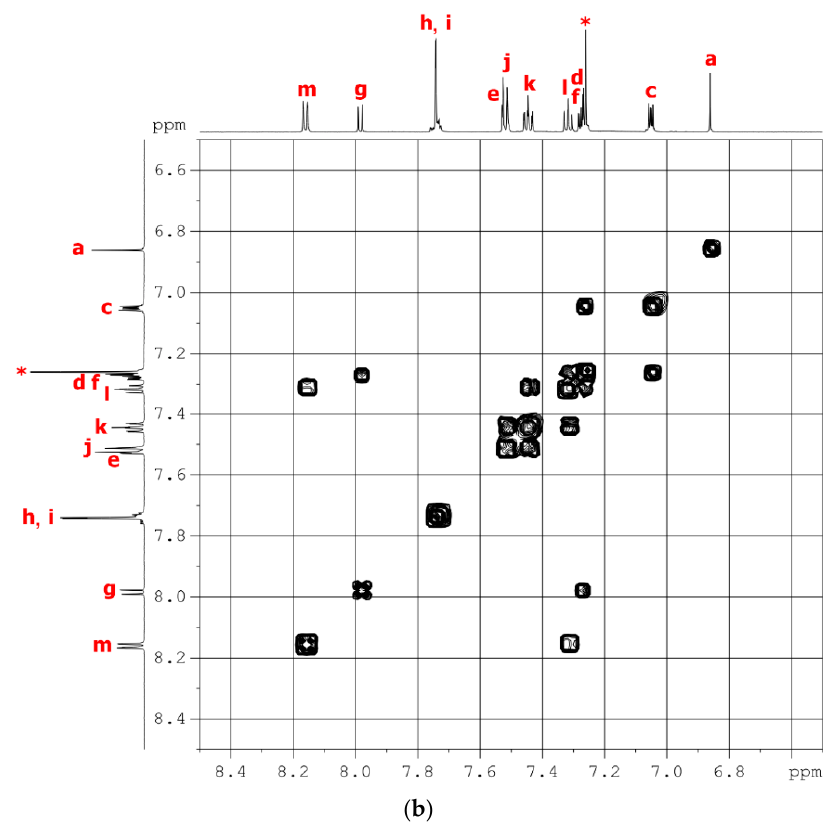
Figure 7. ( a ) 1 H NMR and ( b ) H–H COSY spectra of NPC–TPDI in CDCl 3 (* solvent peak).